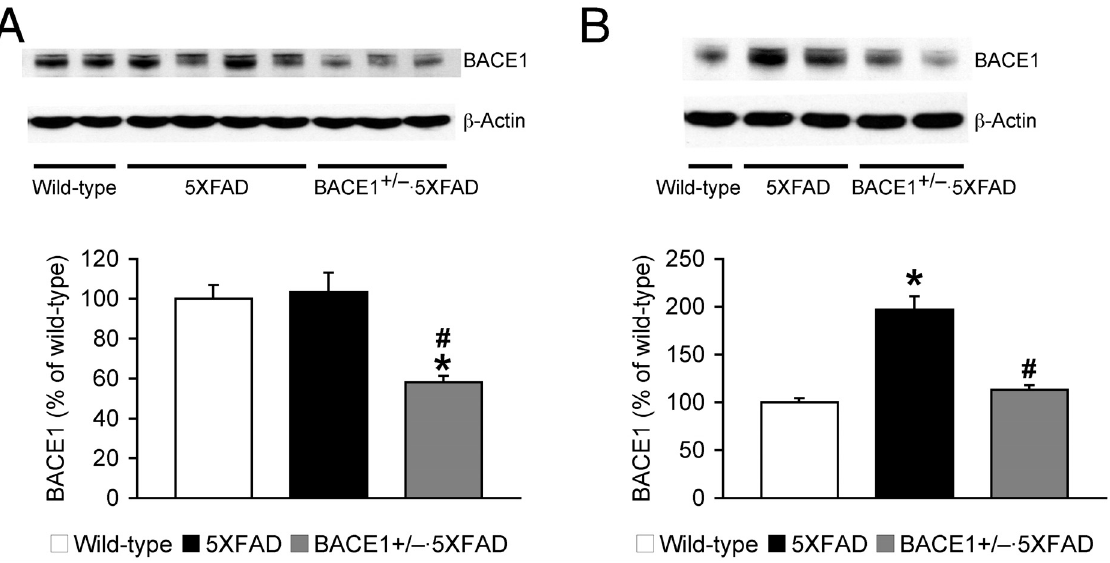
Figure 4. Age-related changes in BACE1 levels and the modification by BACE1 + / 2 deletion in 5XFAD mice. ( A , B ) Immunoblot analysis of BACE1 in hemibrain lysates from wild-type mice and 5XFAD mice with BACE1 + / + or BACE1 + / 2 genotype. Intensities of BACE1-immunoreactive bands of mice at 6 months ( A ) and 15–18 months ( B ) of age were quantified by phosphorimaging and expressed as percentage of wild-type levels ( n =4–8 mice per group). BACE1 + / 2 deletion reduced BACE1 expression by , 50% in 5XFAD mice irrespective age as compared with age-matched 5XFAD mice ( # p , 0.05). However, since BACE1 expression is significantly elevated up to , 200% in 15–18-month-old 5XFAD mouse brains (* p , 0.05 versus wild- type), levels of BACE1 equivalent to wild-type controls remain in BACE1 + / 2 ? 5XFAD brains at the advanced age. All data are presented as mean 6